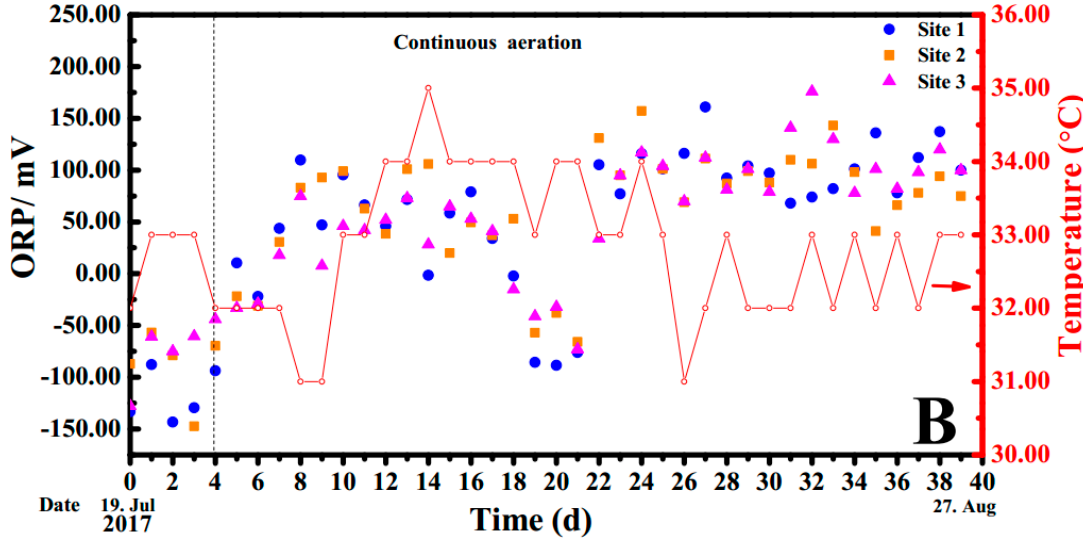
Figure 2. The DO and ORP improvement of river ( A : DO, B : ORP).